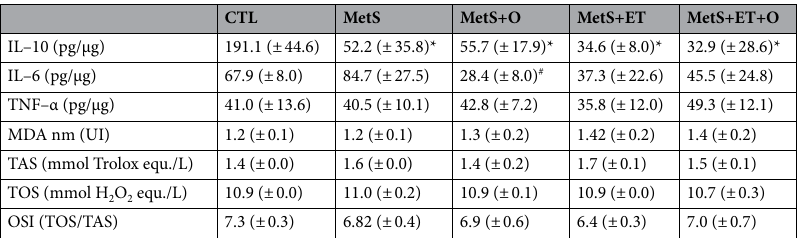
Table 3. Interleukin and analysis of oxidative stress in cardiac tissue. CTL–Control, MetS–Metabolic Syndrome, MetS+O–Metabolic Syndrome and Okra, MetS+ET–Metabolic Syndrome and Exercise Training, MeTS + ET + O–Metabolic Syndrome and Exercise Training and Okra. IL–10–Interleukin −10, IL–6– Interleukin–6, TNF–α–Tumor Necrosis Factor Alpha, MDA–Malondialdehyde, TAS–Total Antioxidant Status, TOS–Total Oxidant Status, OSI–Oxidative Stress Index. *Different from CTL, #Different from MetS. p ≤